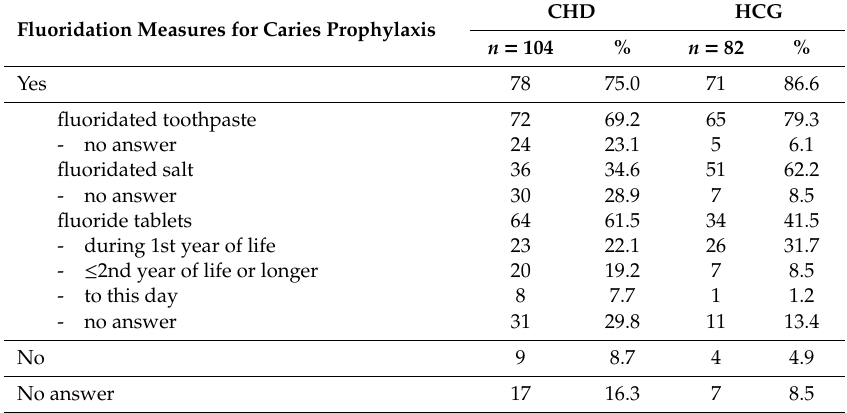
Table 3. Recommended fluoridation measures for caries prophylaxis within the CHD and healthy control group (HCG).